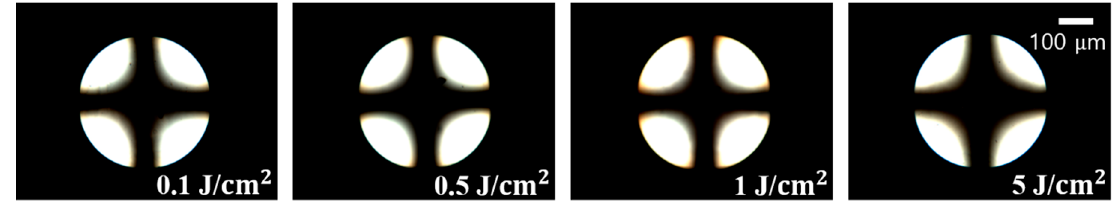
Figure 8. Conoscopic polarized optical microscopy (POM) images of the LC cells fabricated with PCHA100 films, after UV treatment at 0.1, 0.5, 1, and 5 J/cm 2 , respectively; scale bar: 100 μ m, all scale bars are the same.